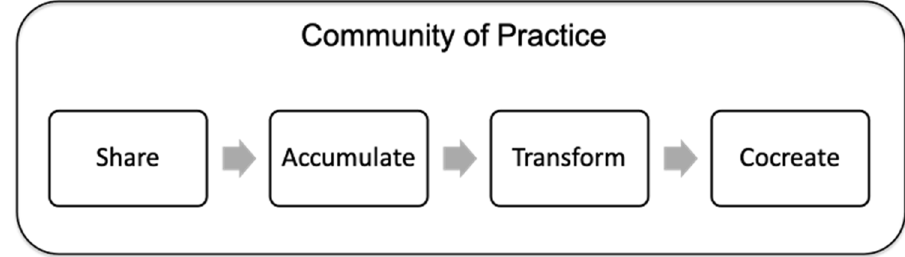
Figure 1. Initial research model.